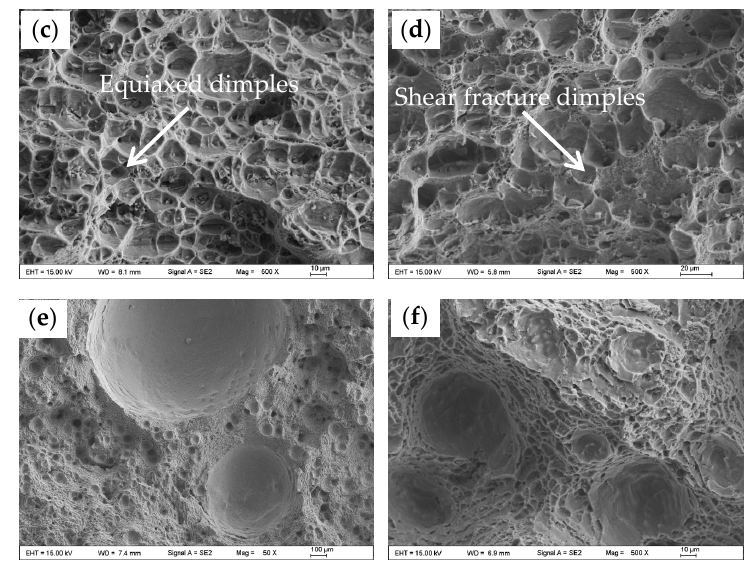
Figure 5. Macroscopic fracture morphologies of as-welded specimens: ( a ) sample No. 2; ( b ) sample No.7. SEM (scanning electron microscope) fracture morphologies of as-welded specimens: ( c ) sample No. 2; ( d ) sample No. 7; ( e ) sample No. 6 at low magnification; and, ( f ) sample No. 6 at high magnification.